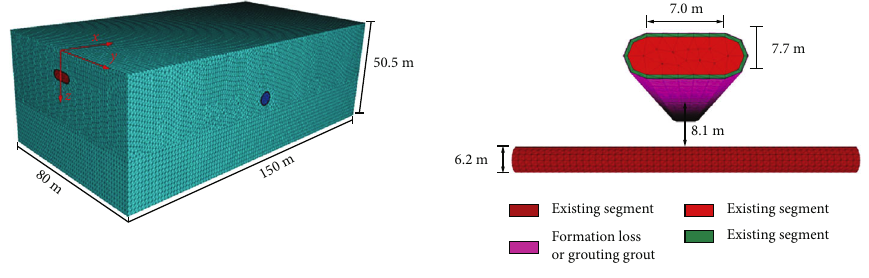
Figure 11: Numerical computation model.